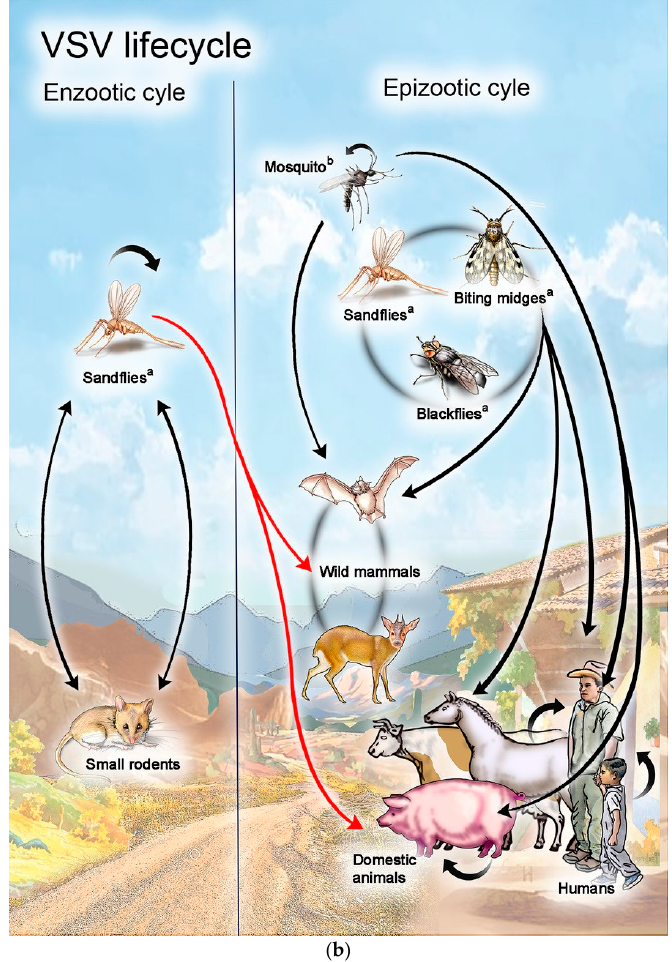
Figure 1. Hypothesized viral life cycle for wild-type ( a ) Ebola virus and ( b ) vesicular stomatitis virus (VSV). Shown are the enzootic cycles (i.e., the predominant, long-term natural host reservoirs of the virus and transmission vectors) and epizootic cycles (i.e., spillover of the virus into other susceptible species and/or alternative transmission vectors). The main natural host reservoir of Ebola virus is thought to be certain species of Old World fruit bats, but the virus is capable of transmission to many other mammalian species [1,7–10]. The natural host reservoir of VSV is thought to be mainly small rodents, such as deer mice, with sandflies acting as transmission vectors; however, VSV is also capable of infecting many other animal species and can be transmitted via other insects [15–32]. a Pool feeders, i.e., hematophagous arthropods that lacerate their host’s blood vessels and then consume the pooled blood. b Vessel feeders, i.e., hematophagous arthropods that consume blood by directly inserting